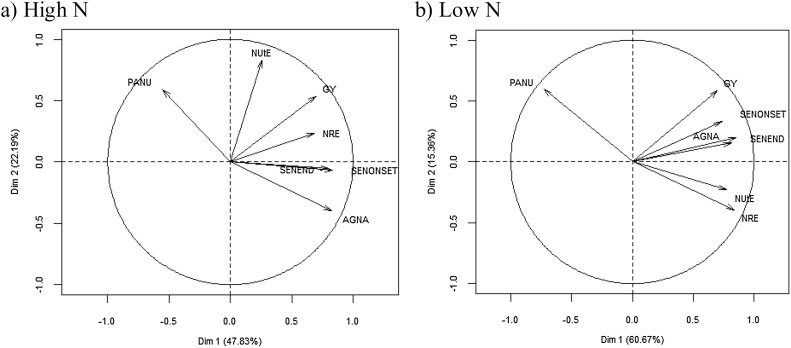
Biplot for grain yield (GY), N-utilization efficiency (NUtE), N remobilization efficiency (NRE), above-ground N at anthesis (AGNA), post-anthesis N uptake (PANU), flag-leaf senescence onset (SENONSET) and flag-leaf senescence end (SENEND) in (a) high N and (b) low N treatments for 30 Indian cultivars (mean of 2013–14 and 2015–16).